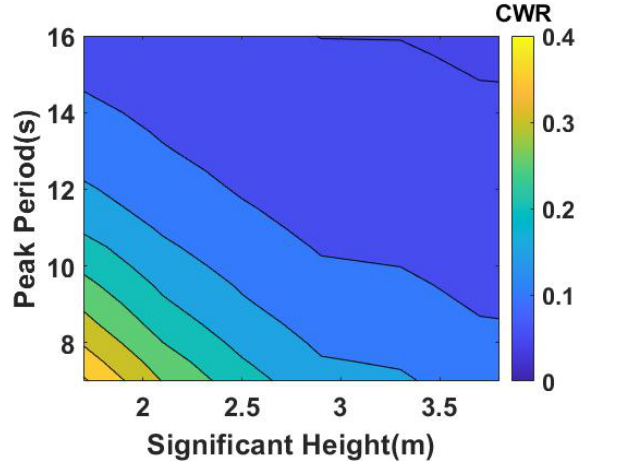
Fig. 15: The CWR of the proposed control with a high control